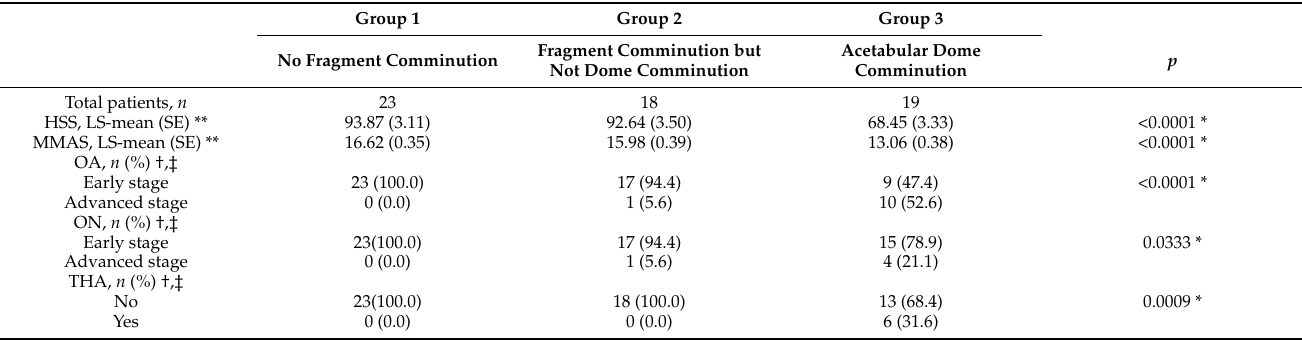
Table 4. The effects of different status of comminution on clinical and radiographic outcomes in patients with